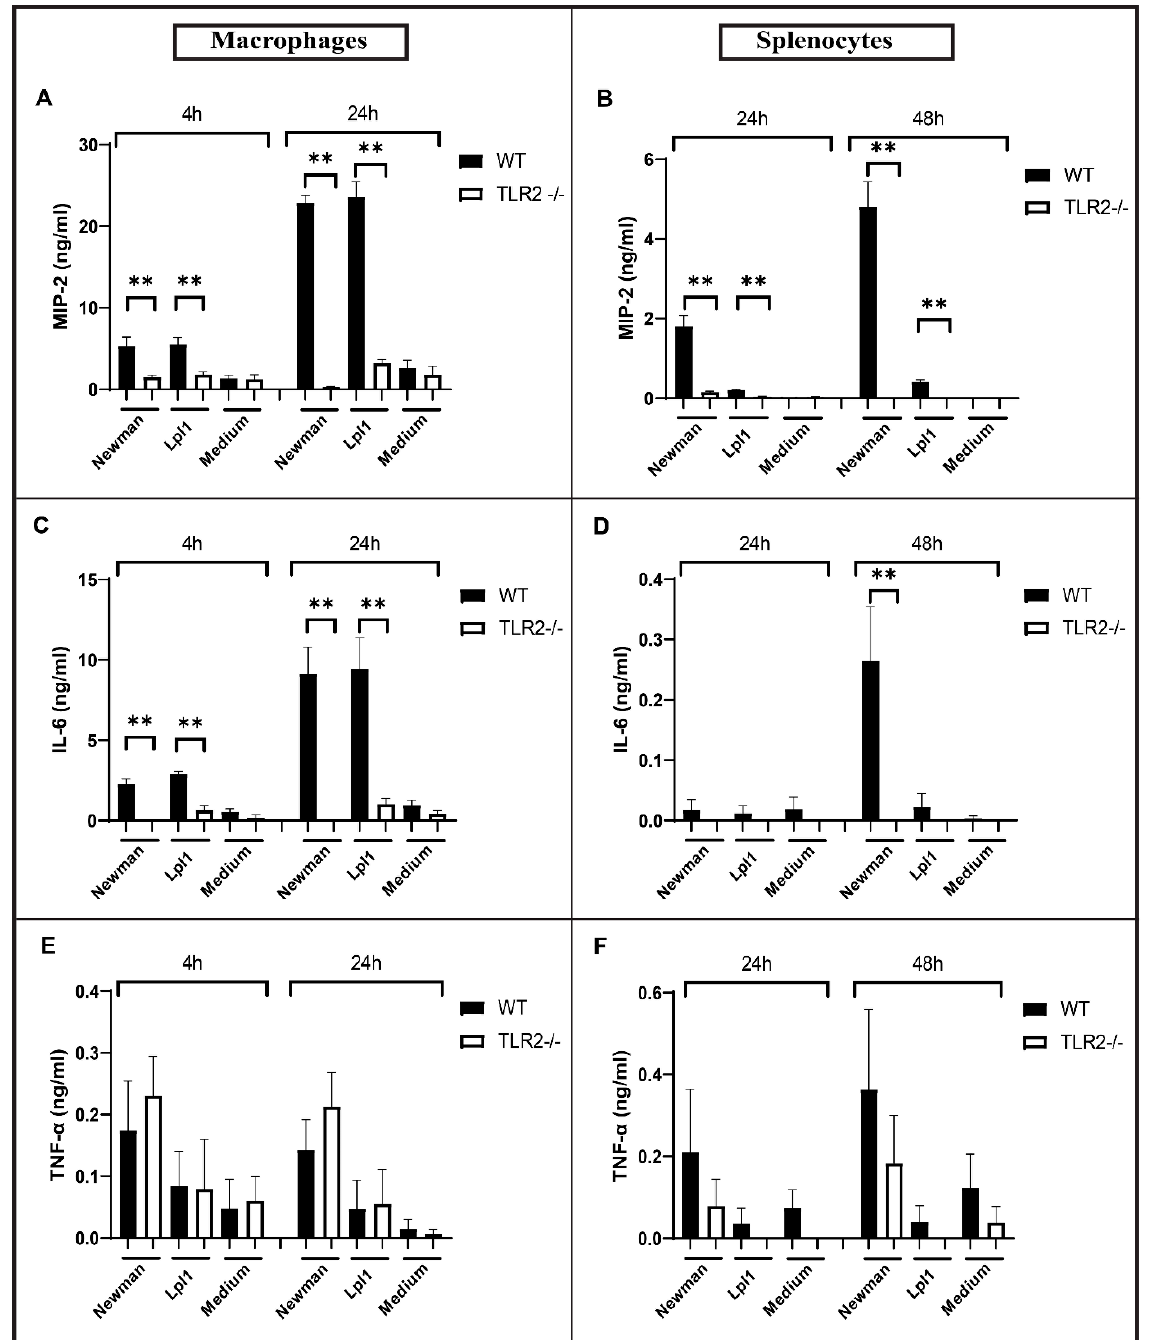
Figure 2. In Vitro stimulation of S. aureus EVs in the peritoneal macrophages and splenocytes of wild-type (WT) and Toll-like receptor 2 deficient mice (TLR2 − / − ). ( A , C , E ) MIP-2, IL-6, and TNF- α stimulation in peritoneal macrophages; ( B , D , F ) MIP-2, IL-6, and TNF- α stimulation in splenocytes. Statistical analyses were performed using the Mann–Whitney U test and the data represented as the mean with SEM ** p < 0.01.